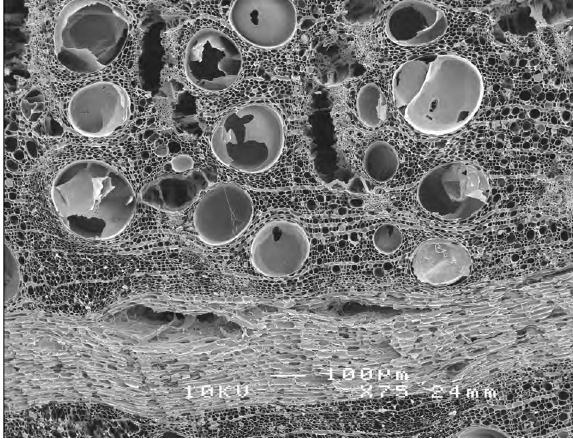
Figure 6: Oak ( Quercus sp. ), grave 415, cross-section (SEM micrograph: Otto